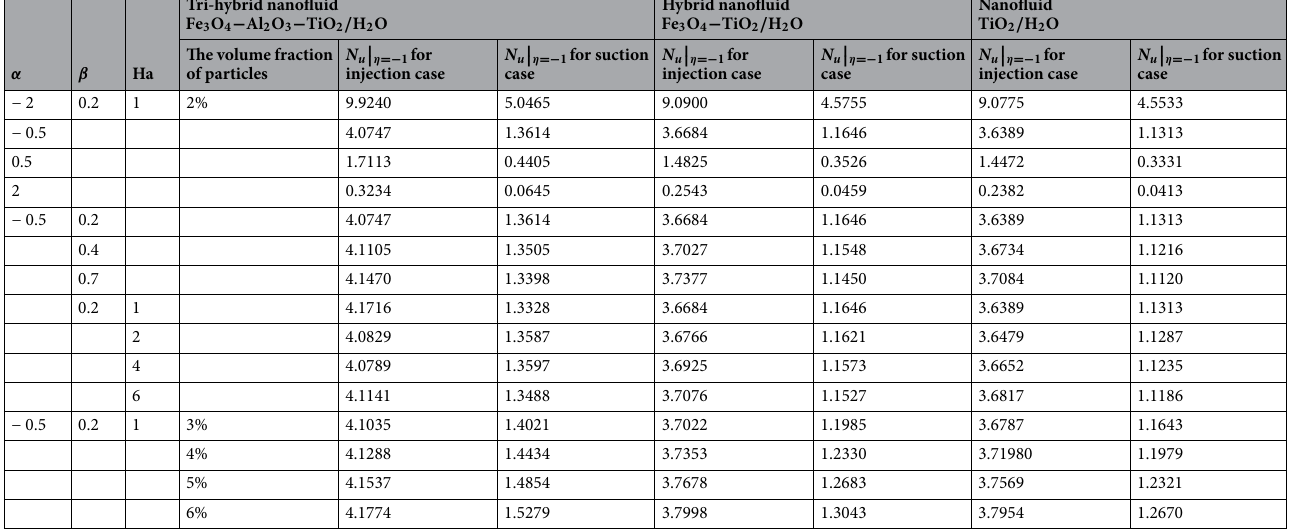
Table 7. Comparison of tri-hybrid nanofluid, hybrid nanofluid, and nanofluid.